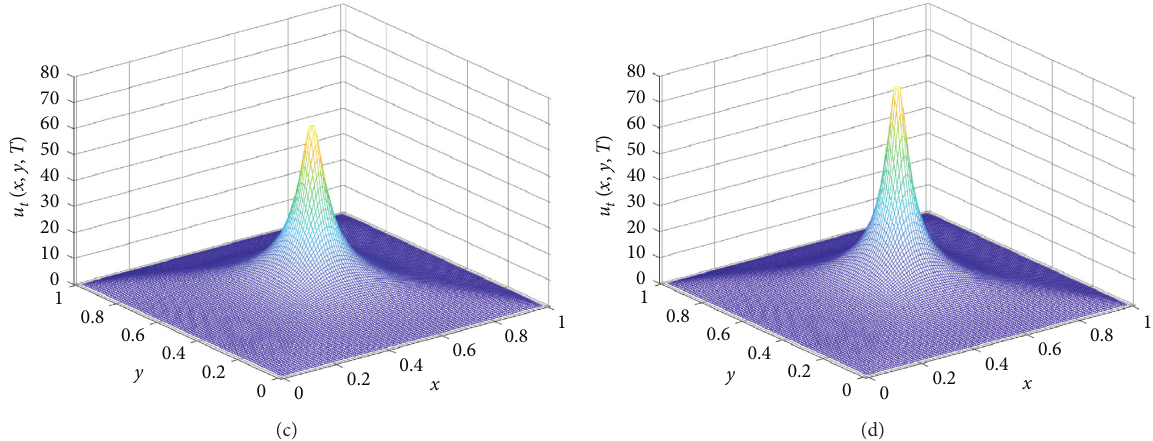
Figure 2: Temporal derivative function, or rate of temperature change, u T � 69 , 700 τ ≈ 0 . 47606037 (b); T � 69 , 720 τ ≈ 0 . 47619698 (c); and T � 69 , 726 τ ≈ 0 . 47623796 (d). The corresponding maximal values are